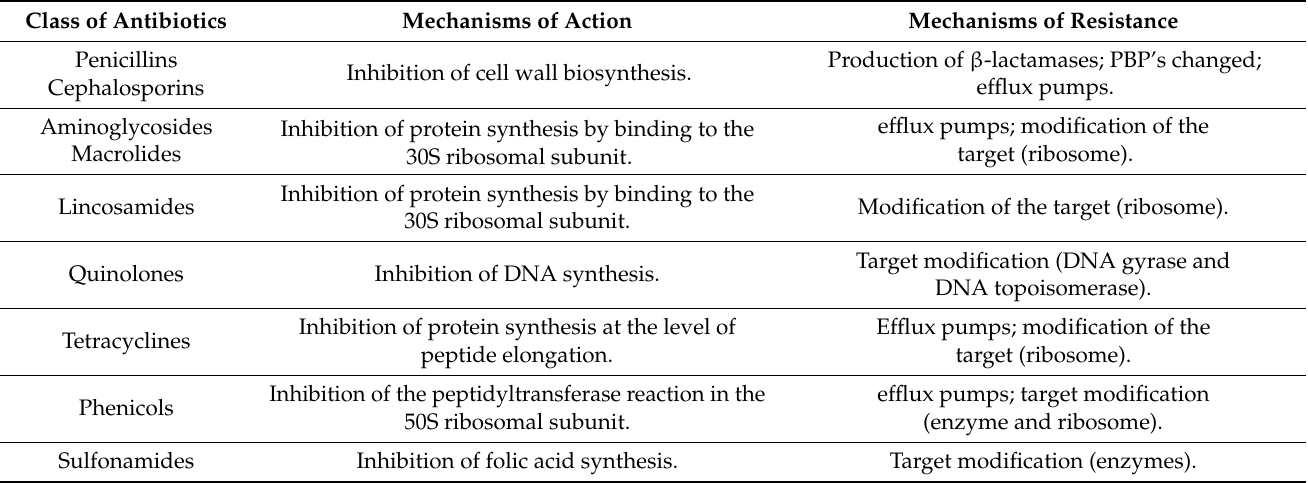
Table 1. Mechanisms of action and resistance of the most important classes of